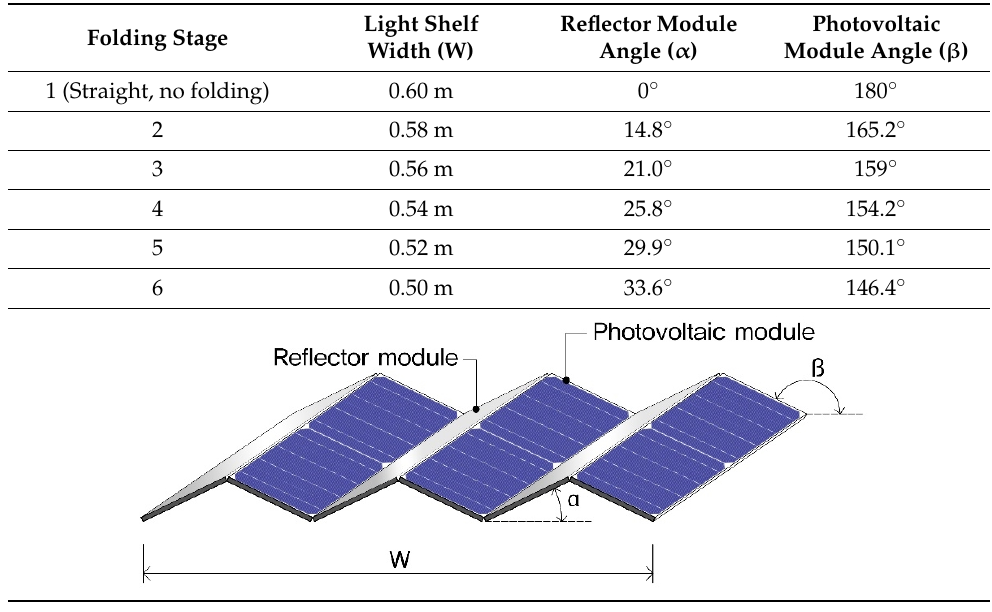
Table 5. Photovoltaic cell specifications.